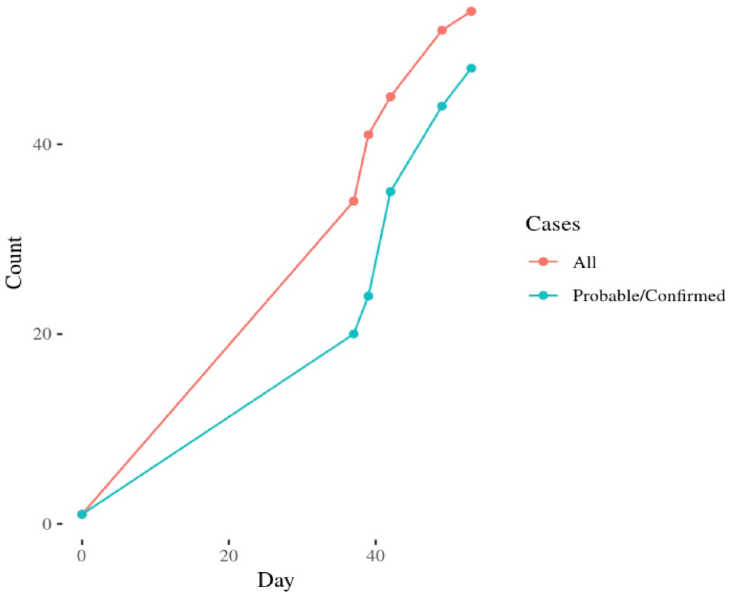
Fig 2. Cumulative case counts used in filtering stochastic branching process